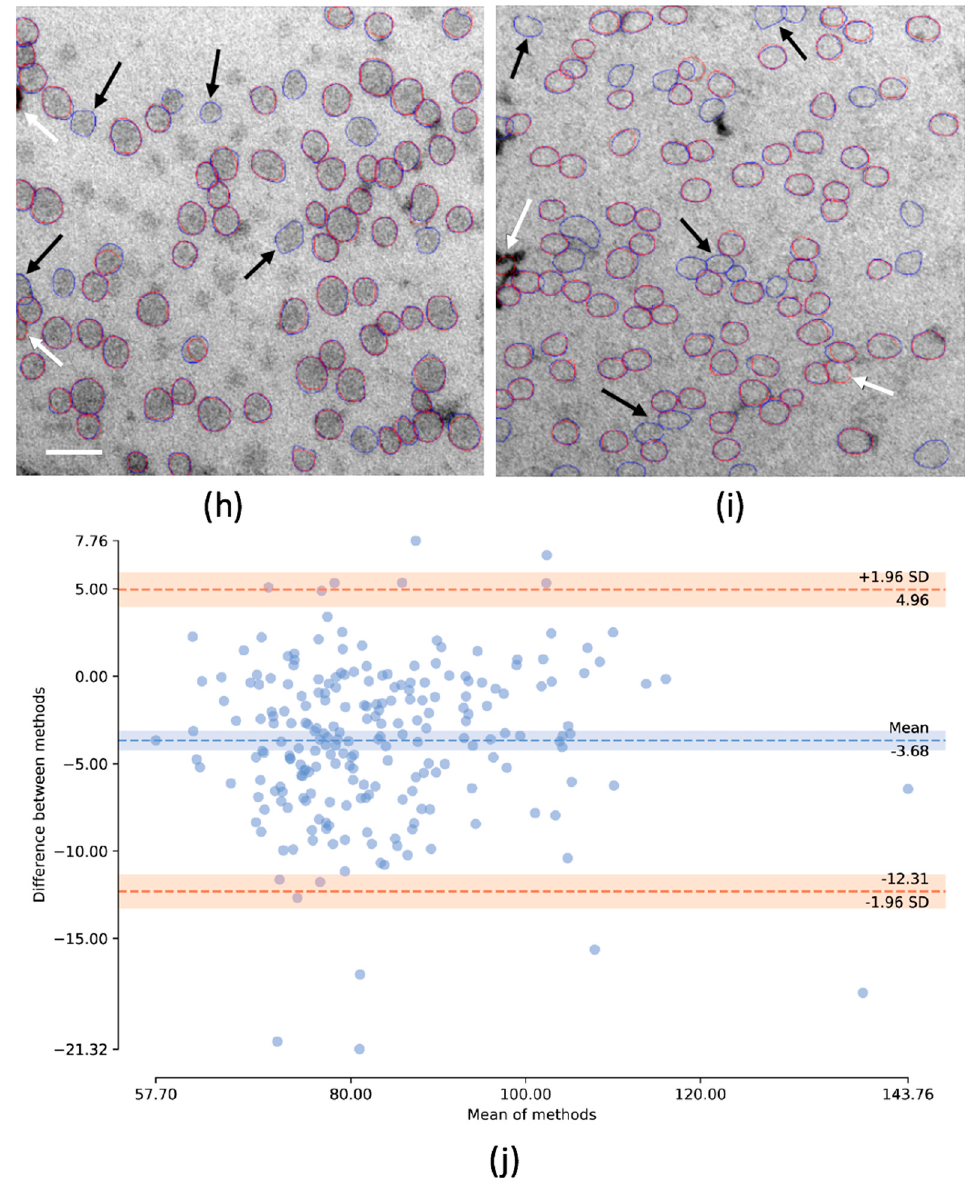
Figure 8. ( a ) A Mask R-CNN architecture. (Figure based on [46,47]). ( b ) A typical image from test set 1, ( c ) its manual annotation, ( d ) the Mask R-CNN output, and ( h ) the manual annotation and Mask R-CNN output overlaid. ( e ) The most challenging image from test set 1 (the image with lowest median average precision (mAP) value), ( f ) its manual annotation, ( g ) the Mask R-CNN output, and ( i ) the manual annotation and Mask R-CNN output overlaid. Arrows in ( h ) and ( i ) highlight selected differences between manual annotations and Mask R-CNN output (white arrows are false positives and black arrows false negatives). ( j ) Bland–Altman plot of agreement between particle sizes estimated automatically (Mask R-CNN) and manually (ground-truth annotation). Scale bars, 50 nm.